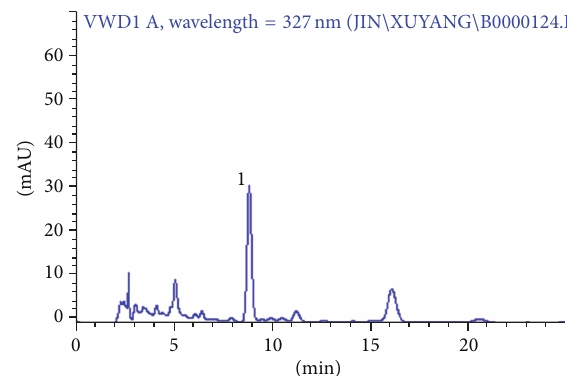
Figure 5: Effect of number of extraction on TPC and chlorogenic acid yield (ethanol concentration, 25%; solid-liquid ratio, 1:20; extraction time, 40min; 𝑛 = 5